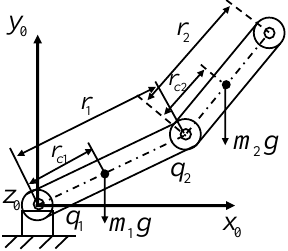
Figure 4. Two-degree-of-freedom manipulator